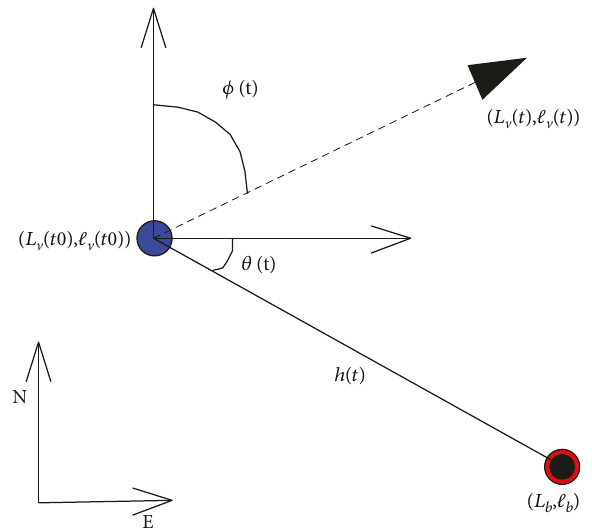
Figure 1: Schematic diagram of the relative position of the